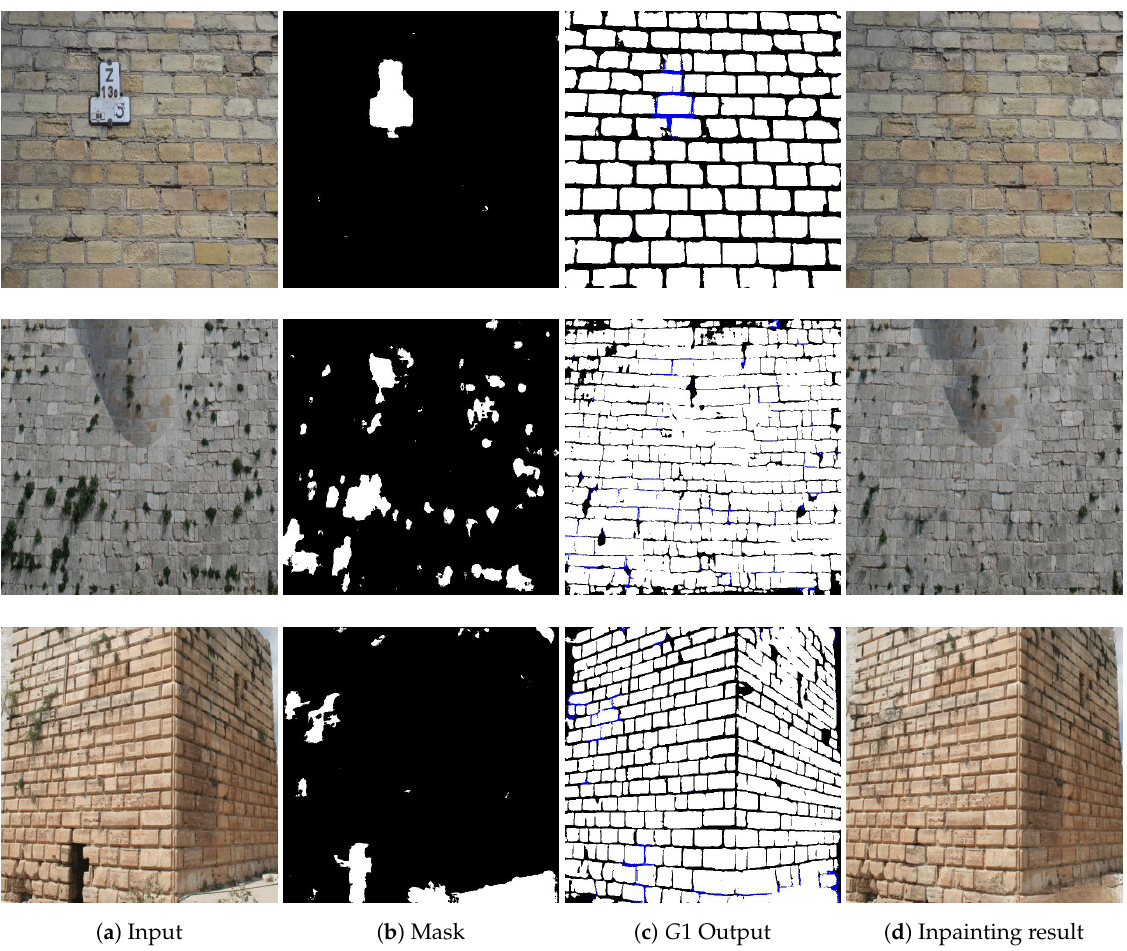
Figure 12. Results of the proposed algorithm (inpainting step) on real scenes with real occlusions (first row: a wall in Budapest, last two rows: ancient walls in